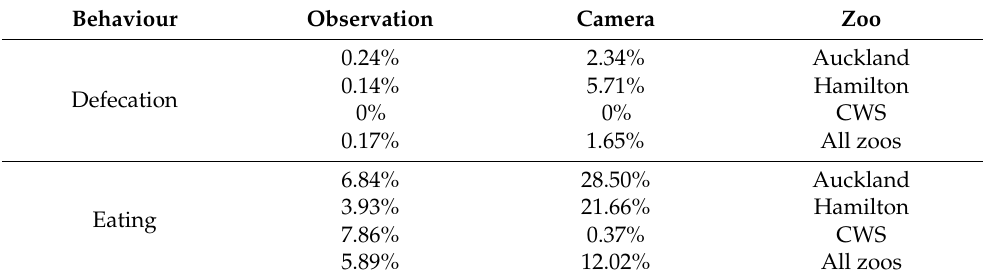
Table 3. Time spent performing behaviours across zoos as determined by two observation methods. Percentages are calculated from the total time observed/observation